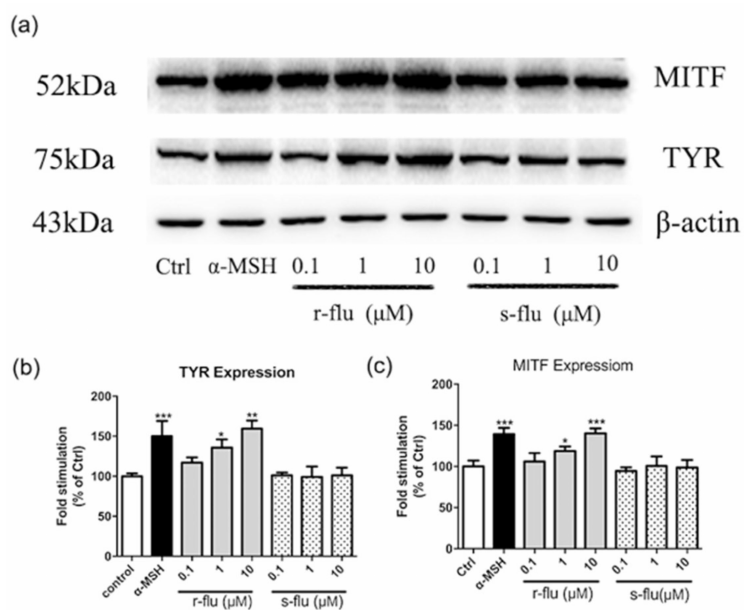
Figure 2. Effect of r-fluoxetine and s-fluoxetine on the expression of the tyrosinase (TYR) and the microphthalmia-associated transcription factor (MITF) in B16F10 cells. ( a ) Western Blot assays were performed to examine MITF and TYR expression levels. ( b , c ) Densitometry scanning of the band densities were utilized to measure the expression of proteins by the Quantity One software. Bars indicate the means ± SEM of three independent experiments. * p < 0.05, ** p < 0.01, *** p < 0.001, compared vs.